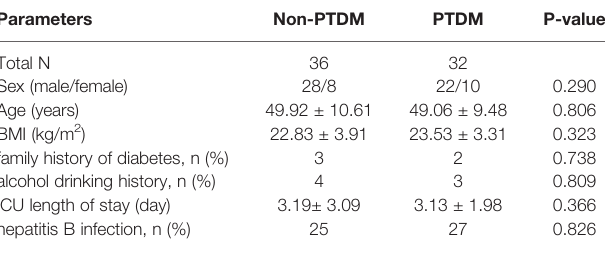
TABLE 1 | Clinical characteristics of the recruited PTDM and non-PTDM recipients.